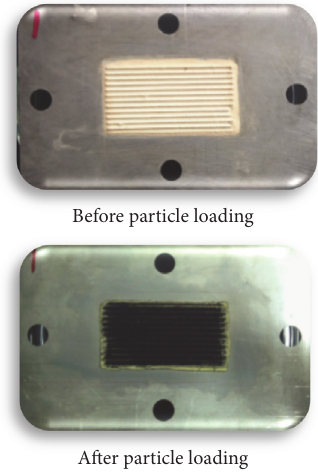
Figure 2: The ceramic